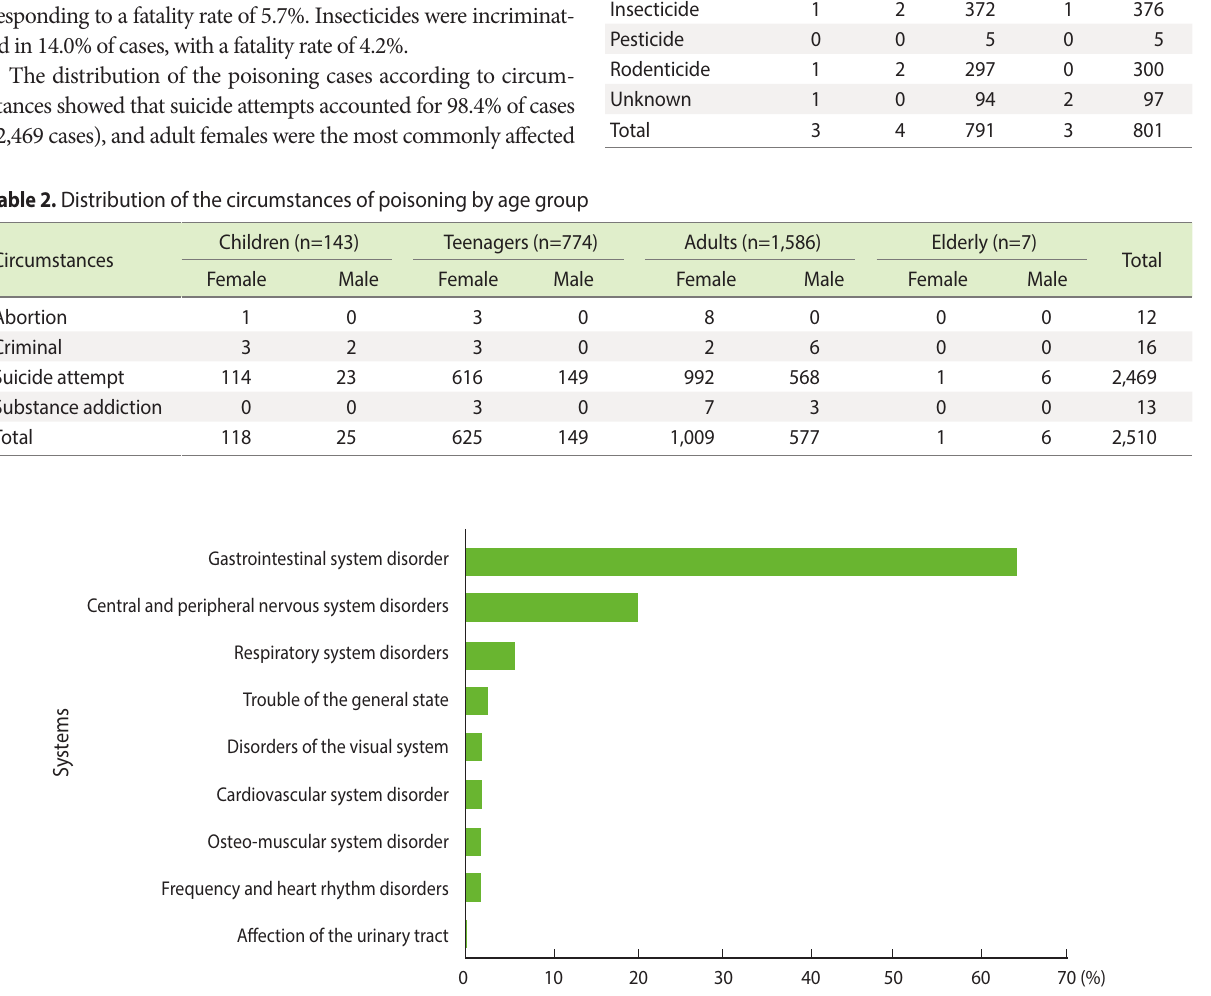
Figure 3. Distribution of clinical manifestations among patients (n=596) intoxicated voluntary by pesticides according to the system or organ concerned